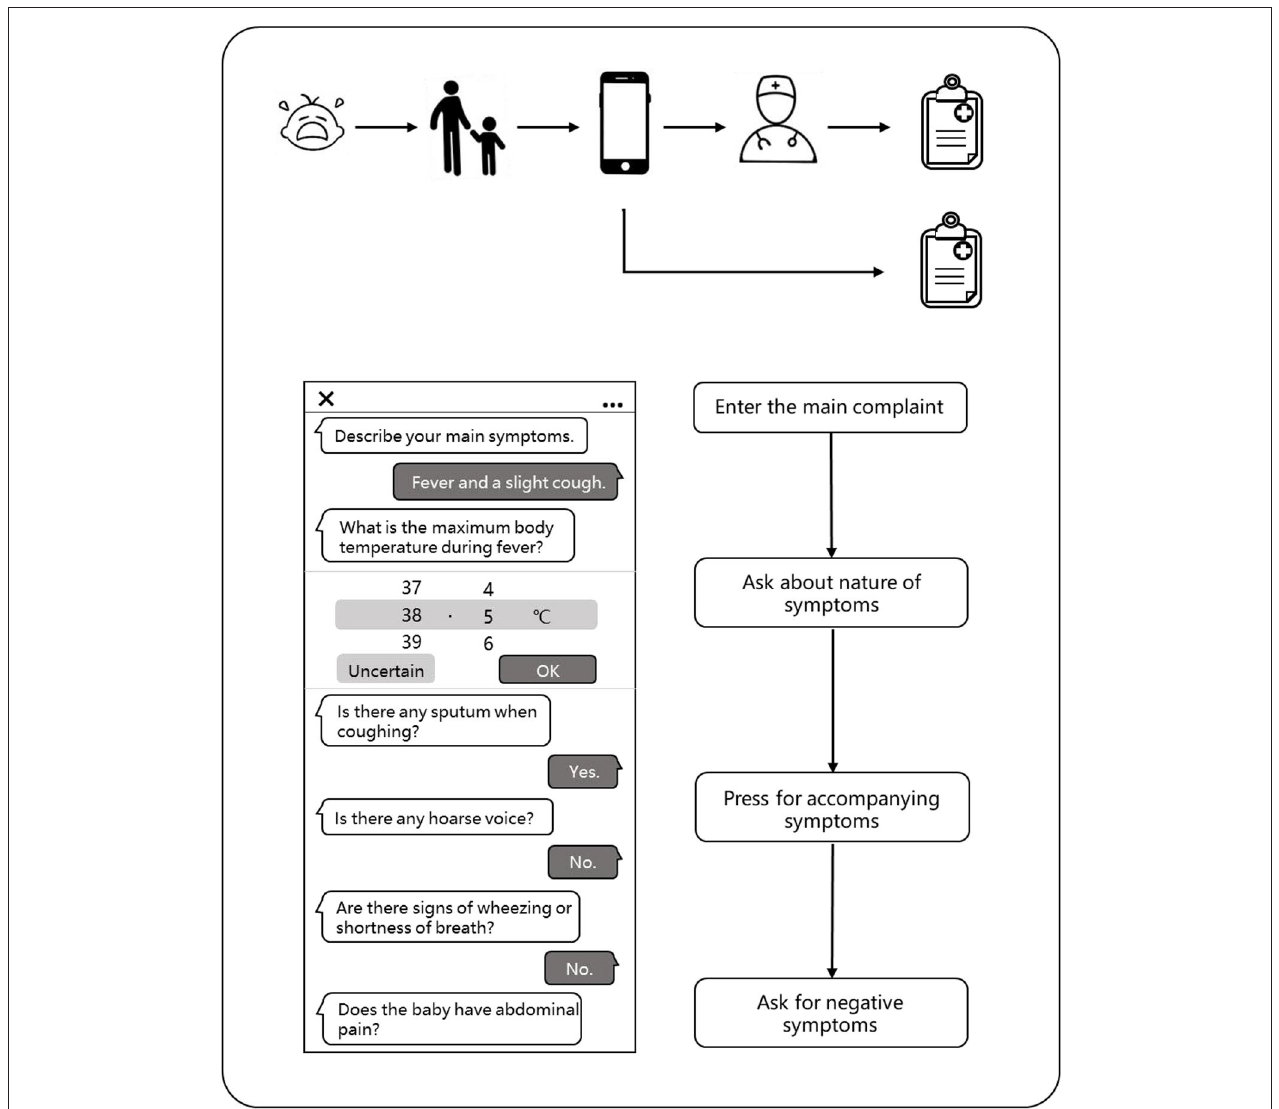
FIGURE 3 | The flow of a visit of the